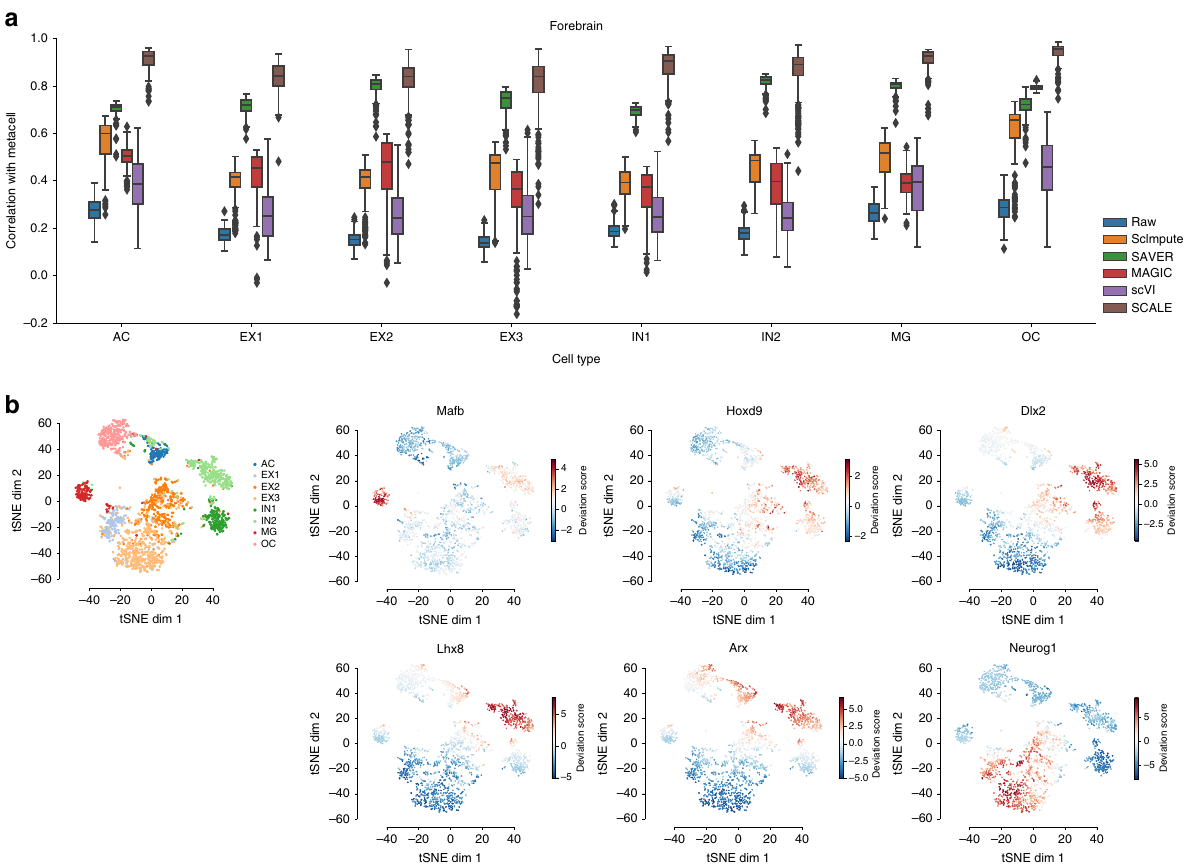
Fig. 3 Data denoising and imputation ef fi ciency on simulation and real datasets. a Comparison of the cell-wise correlations of the raw data and the calibrated data with the meta-cell of each cell type on the Forebrain dataset. b t -SNE embedding of 105 signi fi cant motifs pro fi le identi fi ed by chromVAR (Benjamini-Hochberg corrected Chi-square test p_value_adj of variability <0.05), and embeddings of motifs Mafb, Hoxd9, Dlx2, Lhx8, Arx, and Neurog1 colored by deviation corruption rates, SCALE performed the best, in that the calibrated data most closely correlated with the original meta-cells (Supplementary Fig. 12). We observed similar trends for the other scRNA-seq imputation tools as above, con fi rming the effectiveness of SCALE in enhancing scATAC-seq data. We